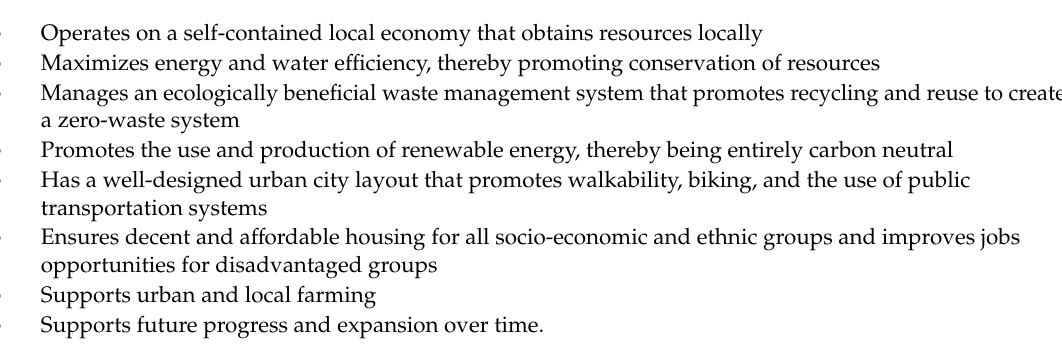
Table 1. Criteria of an ideal eco-city. Sources: